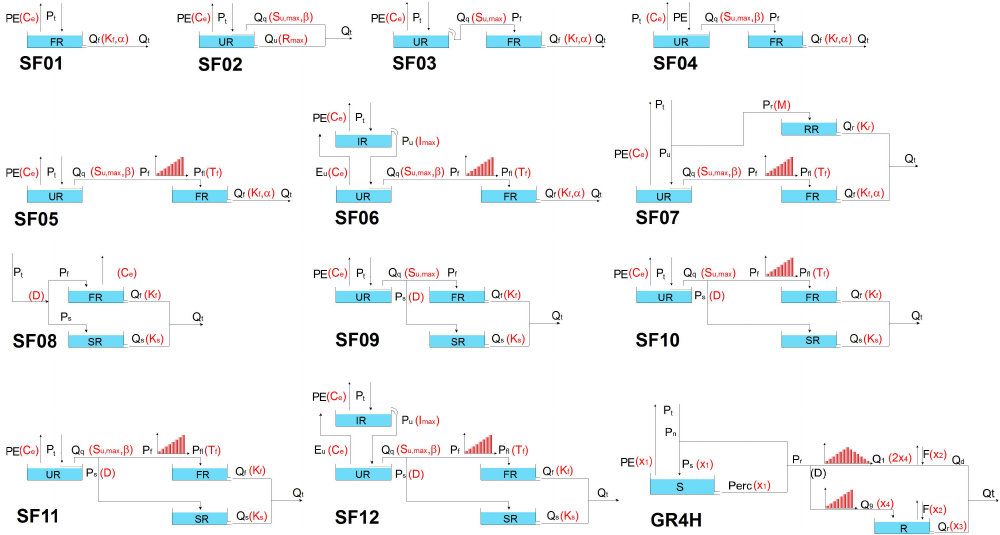
Fig. 2. Schematics of the 12 model structures generated using the SUPERFLEX framework (SF01–SF12 by Fenicia et al., 2013) and the GR4H model (Perrin et al., 2003). A flux of water is denoted in black next to an arrow line. Parameters are given in brackets in red font. Table 3. Main characteristics of the twelve SUPERFLEX structures and GR4H. N res and N θ are the number of reservoirs and calibrated parameters respectively. “Rank” denotes the complexity rank of each structure based on the number of parameters, and number and type of function(s), where 1 is the simplest and 13 is the most complex. Structure N